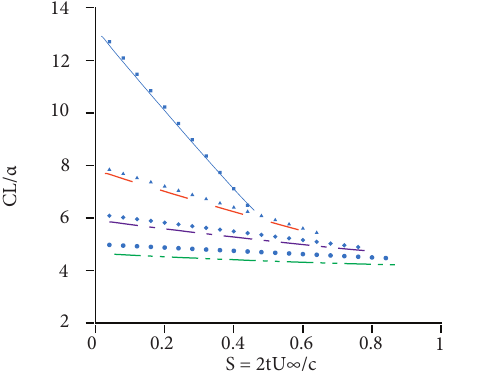
Figure 3. Comparisons of calculation value with theoretical value of lift response.